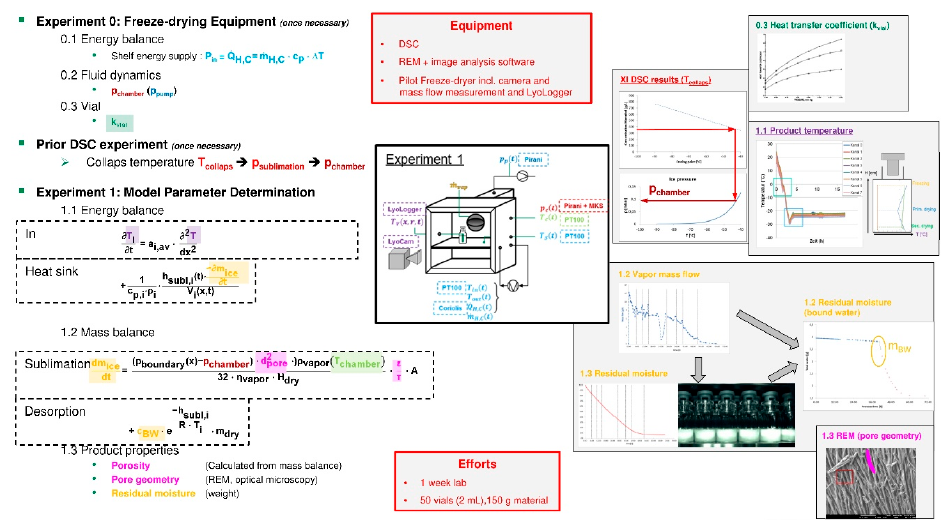
Figure 11 Figure 11. Lyophilization process modeling workflow, recipe, SOP.